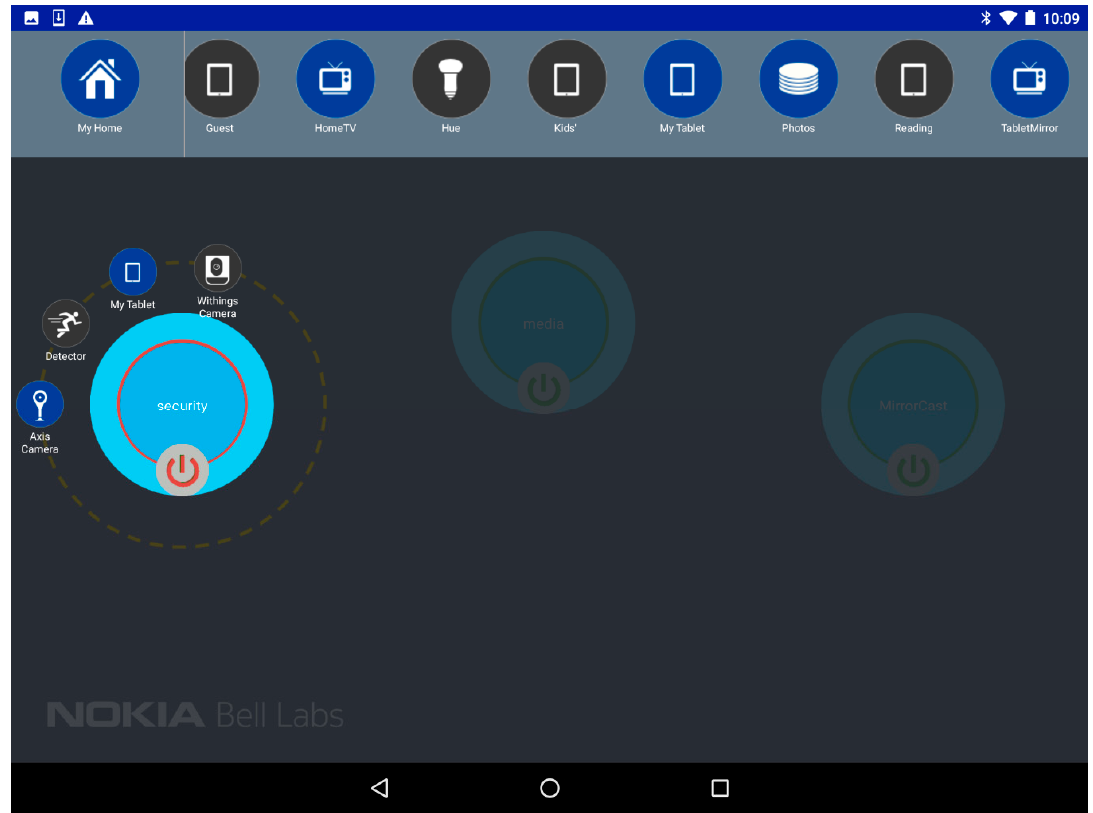
Figure 13. User Interface of the Future Spaces application on an Android tablet.